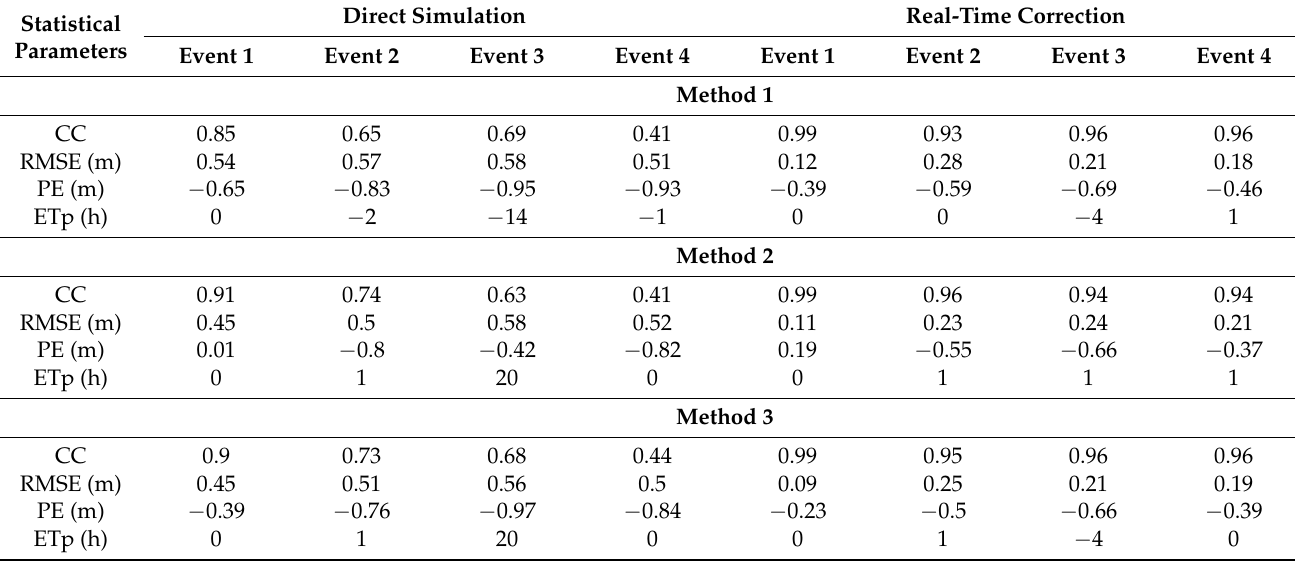
Table 2. Relative comparison of error amount between direct simulation and QPF correction methods for all rainfall